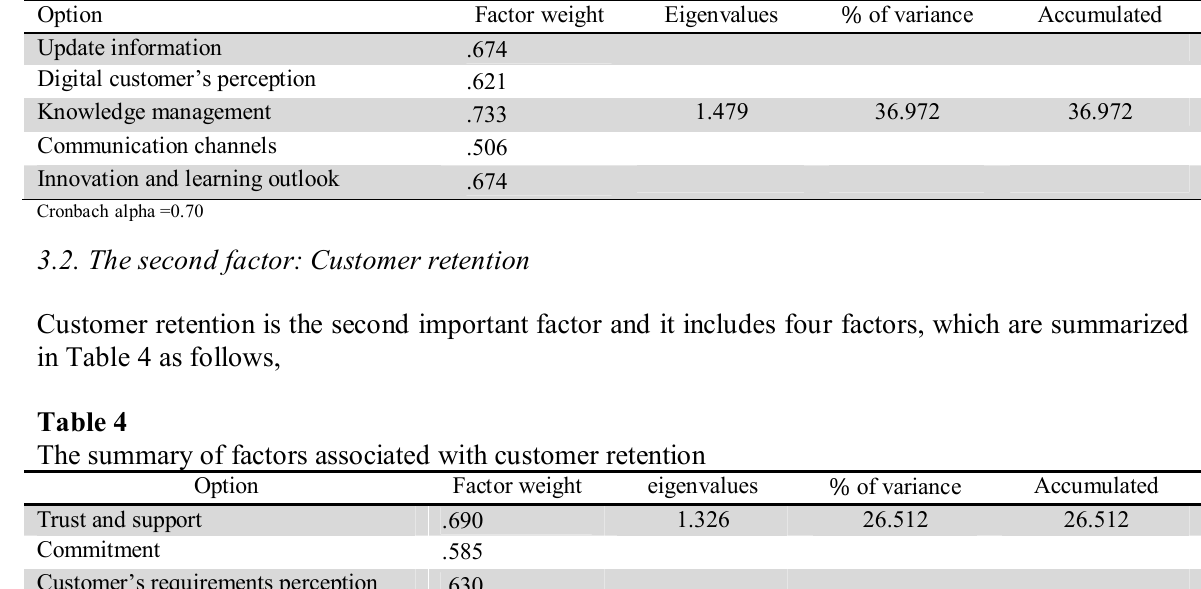
The summary of factors associated with knowledge management